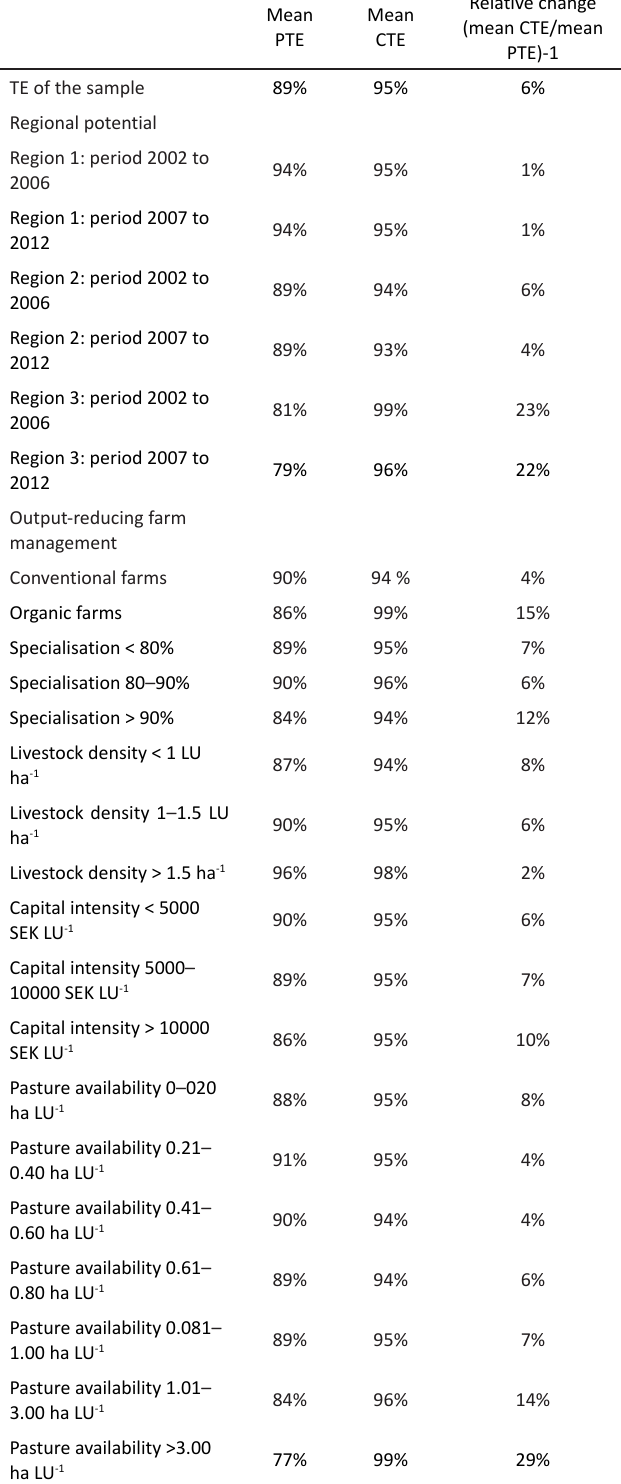
Table 2. Mean pure and compensated technical efficiency and (relative change), ratio (CTE/PTE)-1